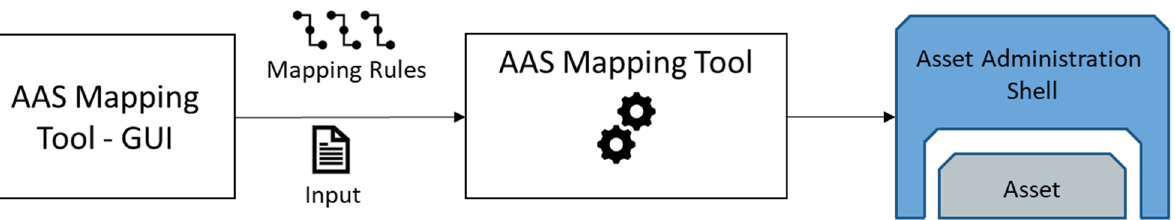
Figure 5. AAS Mapping Tool.